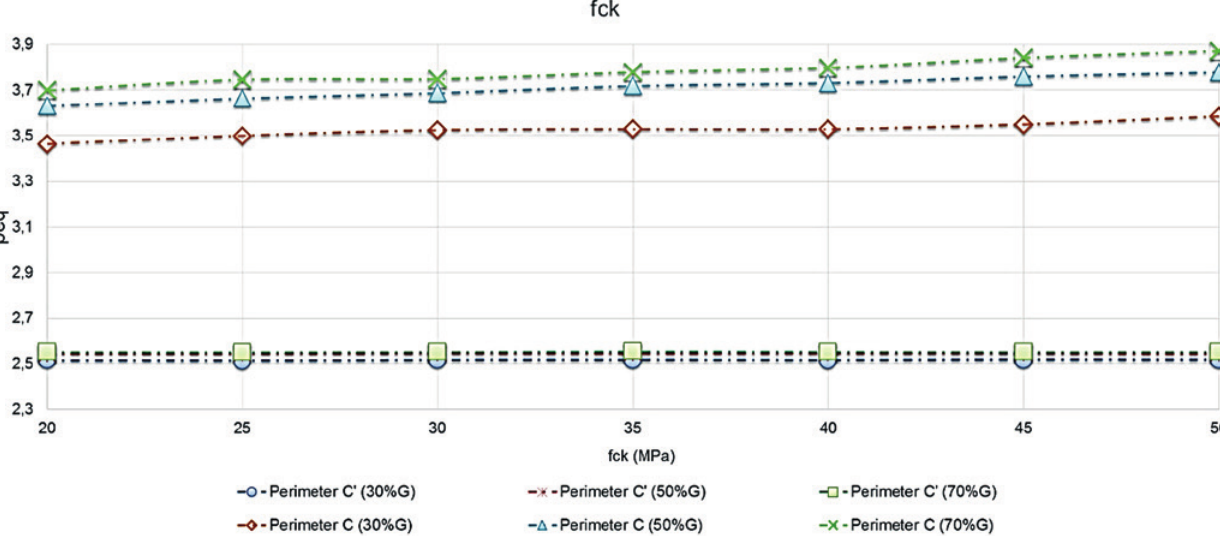
for rectangular column considering the variation of eccentricity y eq β